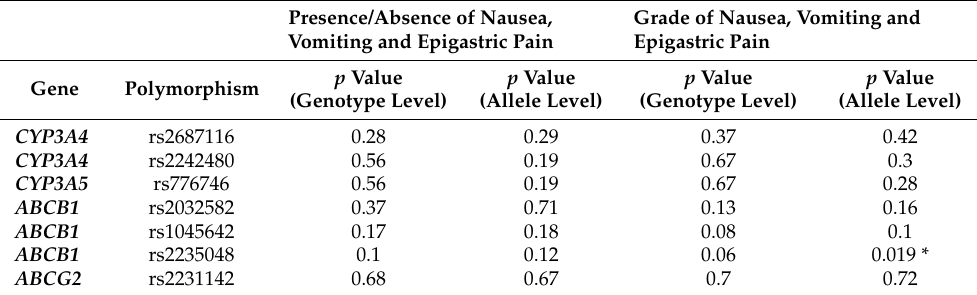
Table 6. p value by chi-squared test at genotype and allele level for the presence/absence and the grade of nausea, vomiting and epigastric pain. Correlation between nausea, vomiting and epigastric pain side effects and polymorphisms linked to MKI